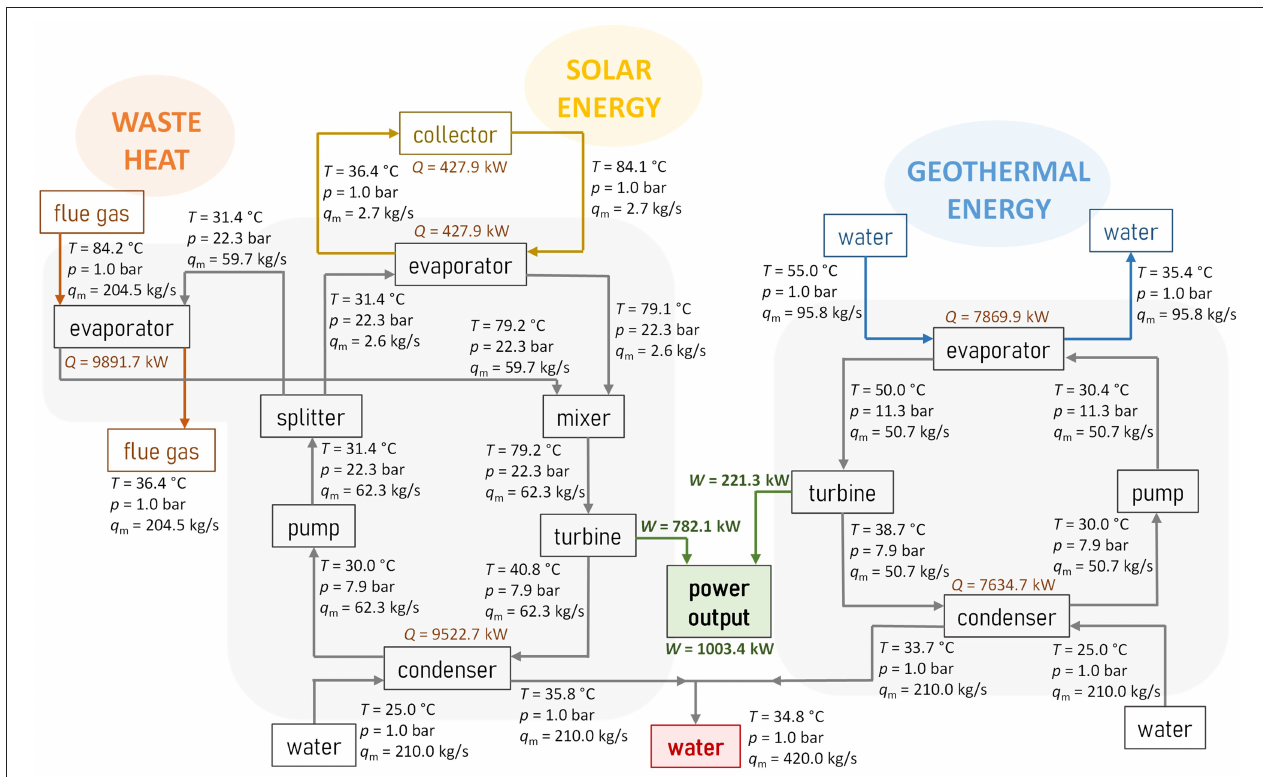
FIGURE 8 | Optimized ORC system when maximizing power output for working fluid